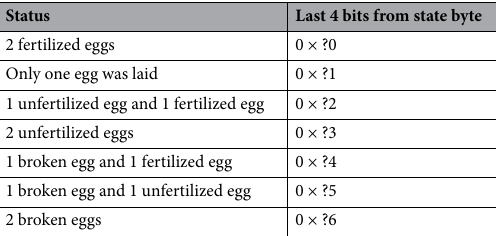
Table 3. Relationship between the eggs status and last 4 bits from State Byte.